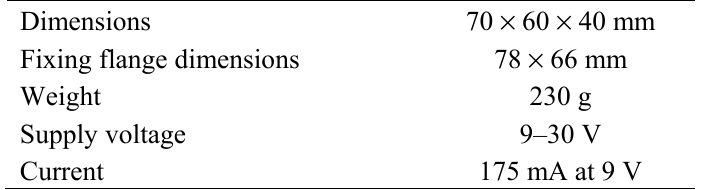
Table 4. Main characteristics of the AXIS-AIS402 inertial measurement unit.